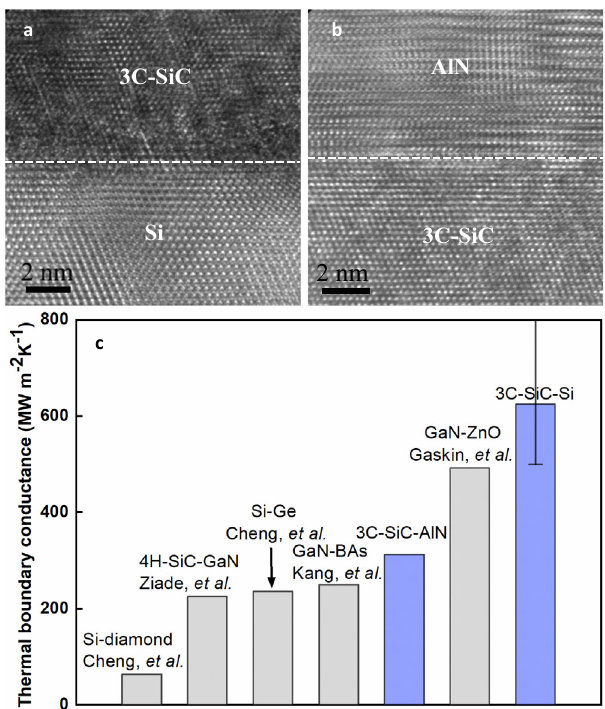
Fig. 5 | High thermal boundary conductance of 3C-SiC epitaxial interfaces. a TEMcross-sectionimageof3C-SiC-Siinterfaces. b TEMcross-sectionimageof3C- SiC-AlN interfaces. c Thermal boundary conductance of 3C-SiC-Si interfaces and 3C-SiC-AlN interfaces. The TBC values of other semiconductor interfaces are included for comparison 28,36 – 38,40,41 . The de fi nition of error bars can be found in